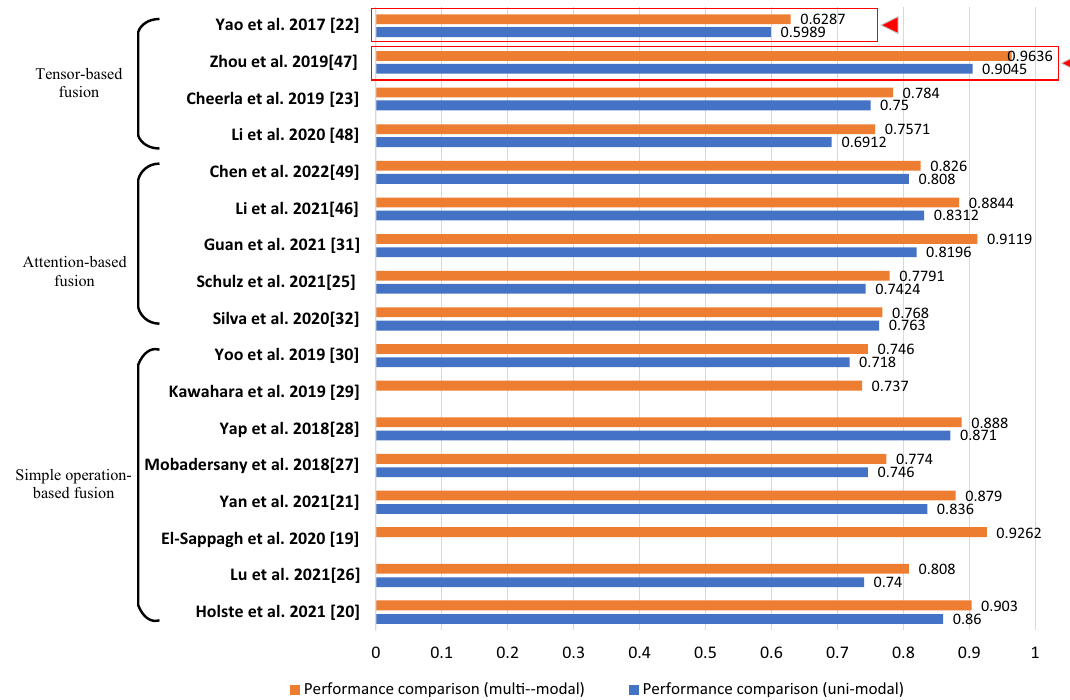
Fig. 3 Comparison of multi-modal fusion performance